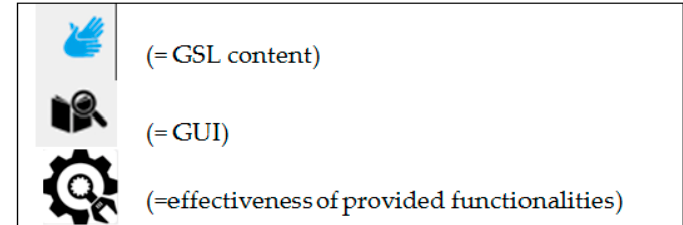
Figure 14. Non-verbal indicators of evaluated aspects.